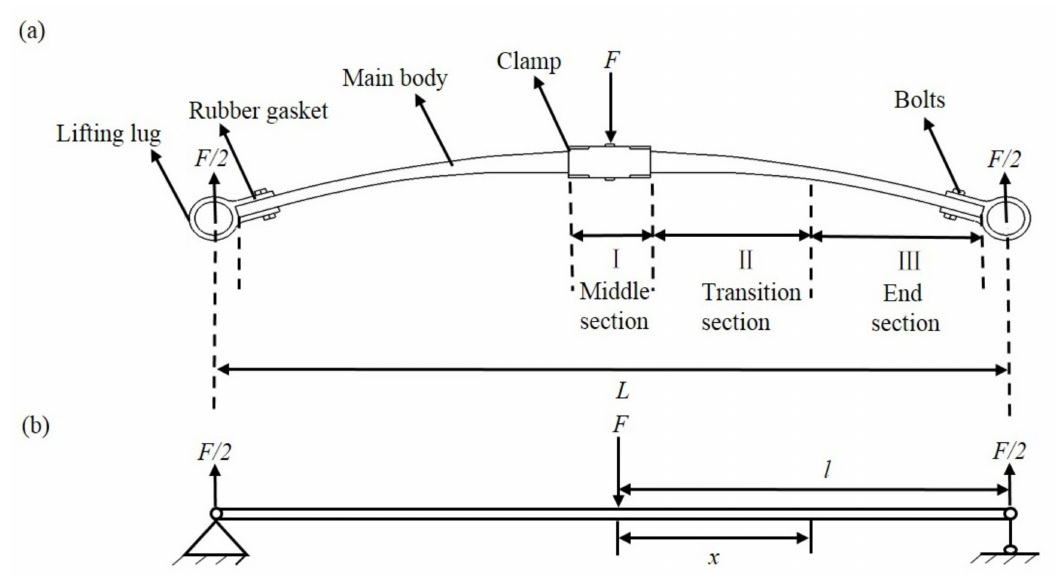
Figure 2. ( a ) Schematic diagram and ( b ) simplified force model of the composite leaf